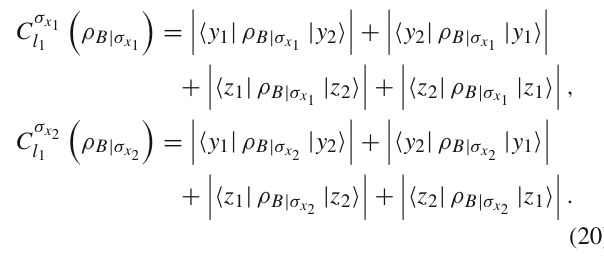
respectively.Thehorizontallines(dottedline,red;dottedline,blue;dot- ted line, azure) denote the right-hand sides of Eqs. (9), (11) and (13). Hereafter, NAQC-limit represents the violation limit with NAQC; BN- limit represents the violation limit with Bell nonlocality, and Steering- limit represents the violation limit with quantum